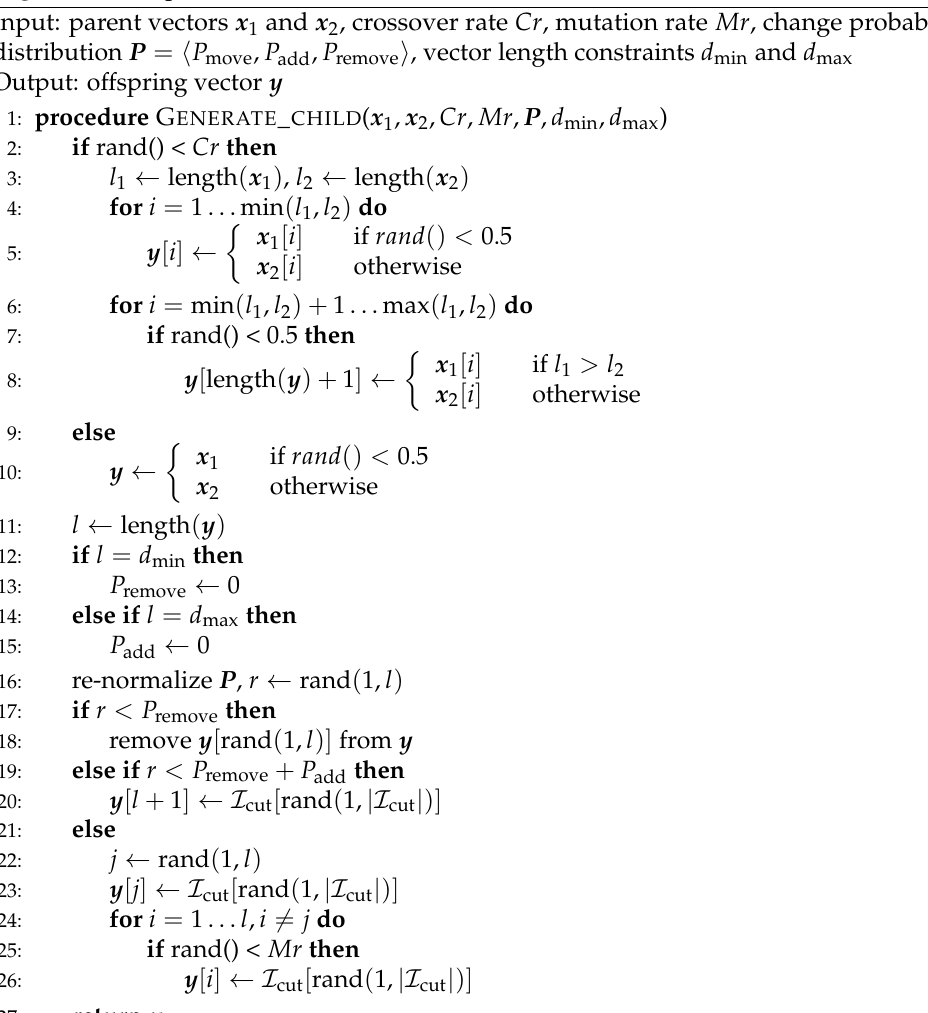
Algorithm 2 Implementation of crossover and